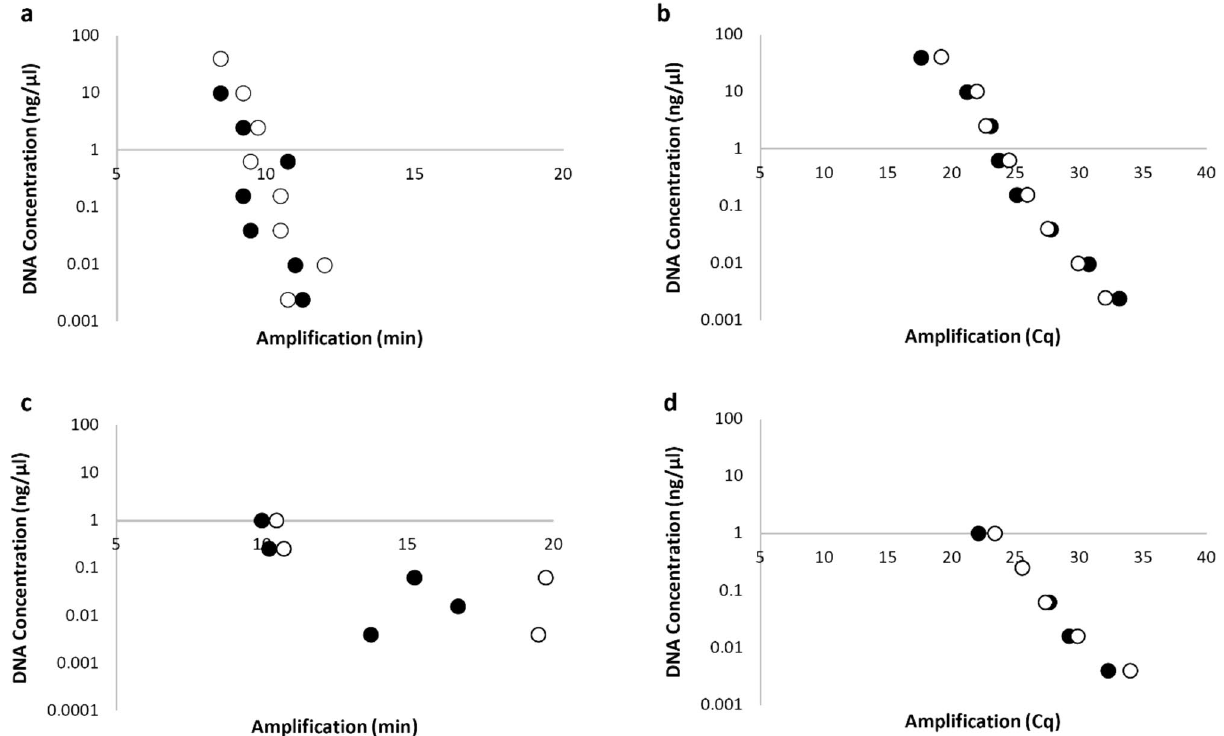
Figure 6. DNA sensitivity test of FAW LAMP and FAW real-time PCR assays. ( a,b ) A four-fold DNA dilution series of two biological replicates of FAW larvae (VAITC 10707 and 10726) DNA amount ranging from 40.0 ng/ µL to 2.441 × 10 –3 ng/µL. ( a ) FAW LAMP assay amplification time, sensitive to all 8 DNA dilutions tested. ( b ) Real-time PCR Cq values sensitive to all 8 dilutions tested. ( c,d ) A four-fold DNA dilution series of two biological replicates of FAW adult moth (VAITC 10728 and 10729) DNA amount ranging from 1.0 ng/µL to 6.1 × 10 –5 ng/µL. ( c ) FAW LAMP assay amplification time, sensitive to only 5 out of 8 DNA dilutions tested. ( d ) Real-time PCR Cq values sensitive to only 5 out of 8 DNA dilutions tested. Black and white circles represent biological replicate DNA